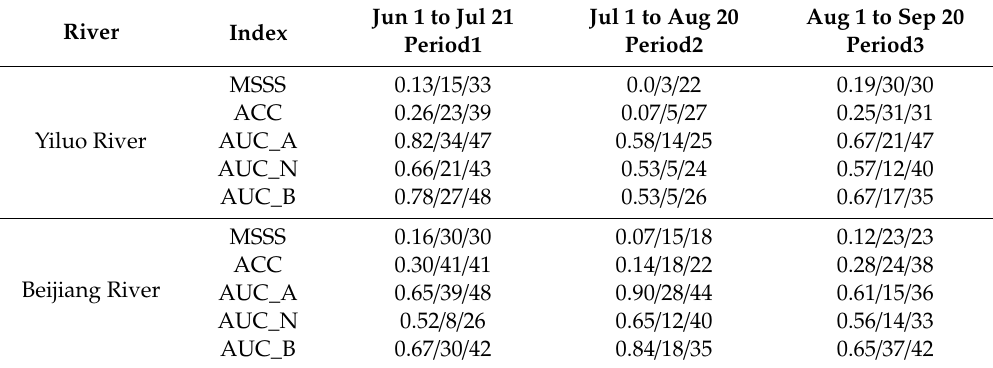
Figure 3. Skilful daily indices for ( a – c ) the Yiluo River and ( d – f ) the Beijiang River for Period1, Period2 and Period3, respectively (Only positive values of the mean square skill score (MSSS) and anomaly correlation coefficient (ACC), and AUC-0.5 are illustrated to show skilful days. a and d , b and e , c and f are for Period1, Period2 and Period3 respectively.). Table 3. Temporal mean of MSSS, ACC and AUC during the 51-day forecasted